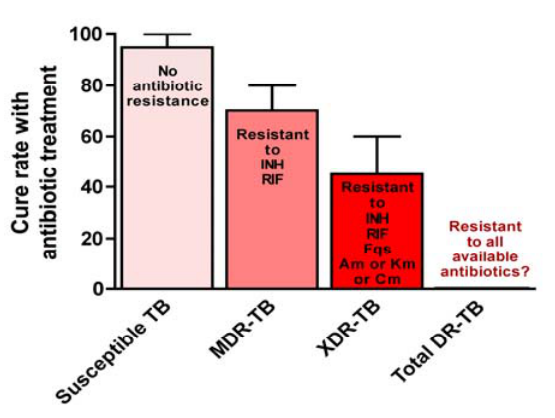
Figure 1. Antibiotic cure rates of TB based on drug resistance patterns. Estimated cure rates for antibiotic-susceptible TB, MDR-TB, and XDR-TB in HIV-negative patients are >95%, 60–80%, and 30–60%, respectively [60–63]. Although TB strains exhibiting resistance to all first-line and drug-resistant (DR)-TB would be untreatable with existing chemotherapeutic agents. INH,